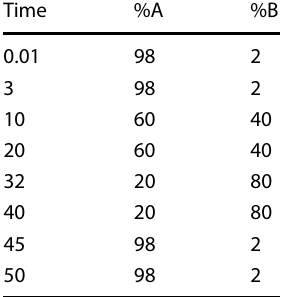
Table 2 Gradient